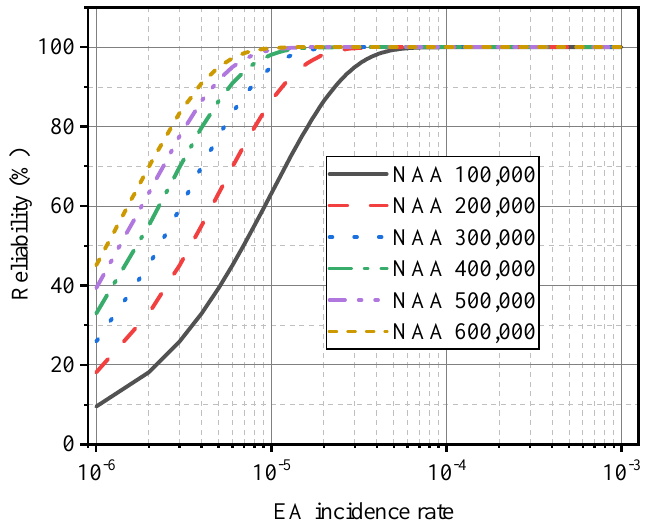
Figure 4. Reliability analysis of the EA incidence rate of different numbers of arrival aircraft